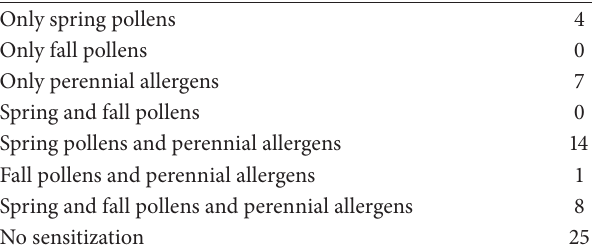
Table 3: Allergic sensitization in